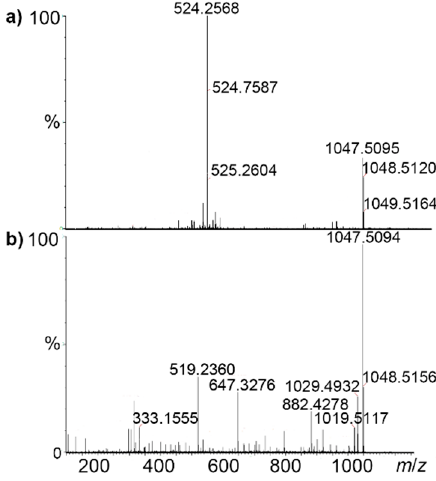
/ MS spectra of protonated